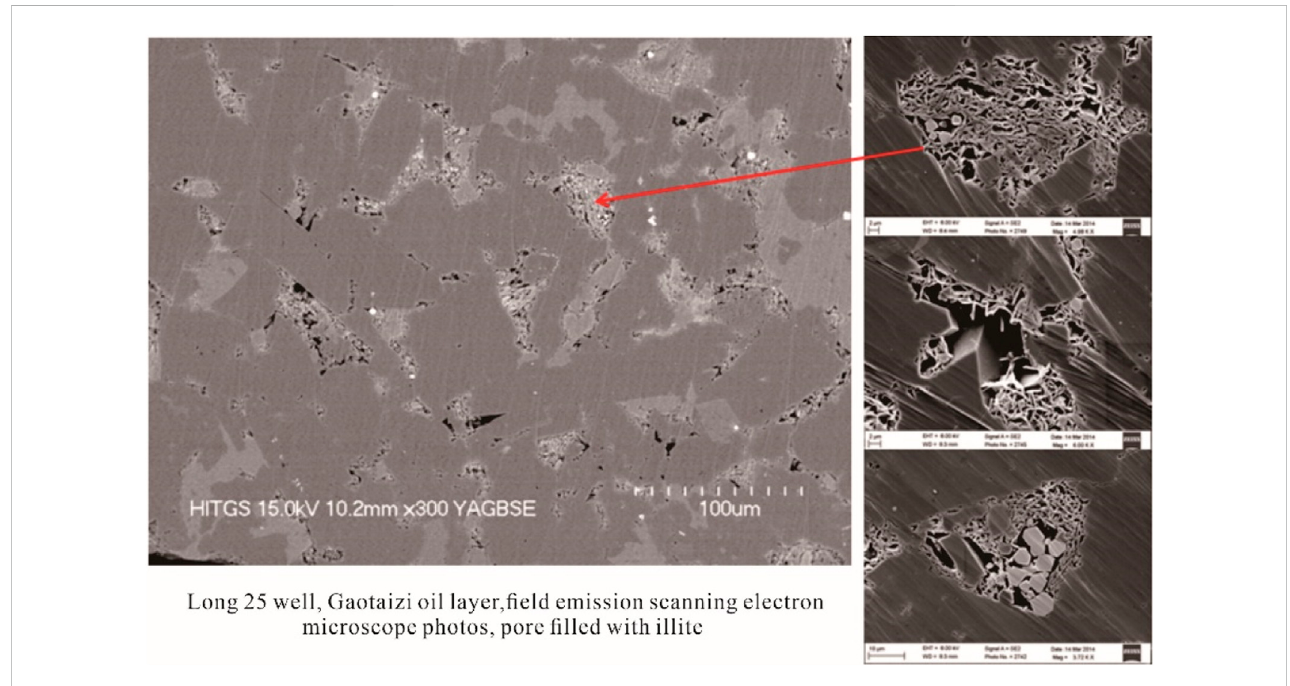
FIGURE 13 Developmental characteristics of the illite clay minerals in the Gaotaizi reservoir under fi eld emission scanning electron microscopy.